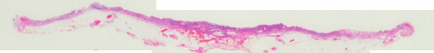
F 4: Cross-section made at the yellow line in Figure 3 and stained with hematoxylin and eosin. Pathological diagnosis was well-differentiated adenocarcinoma, (480 m), ly0, v0, and margin 𝜇𝜇